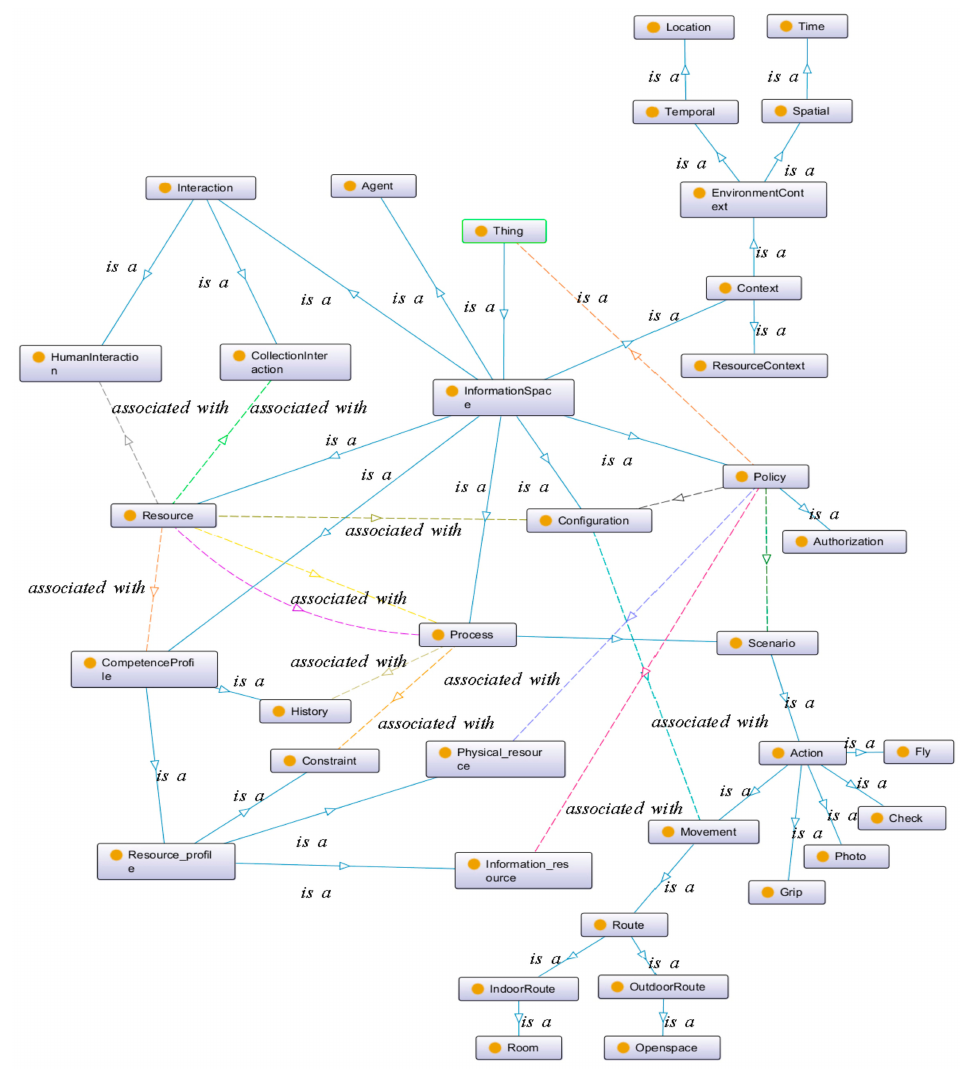
Figure 5. An ontology of the information space in